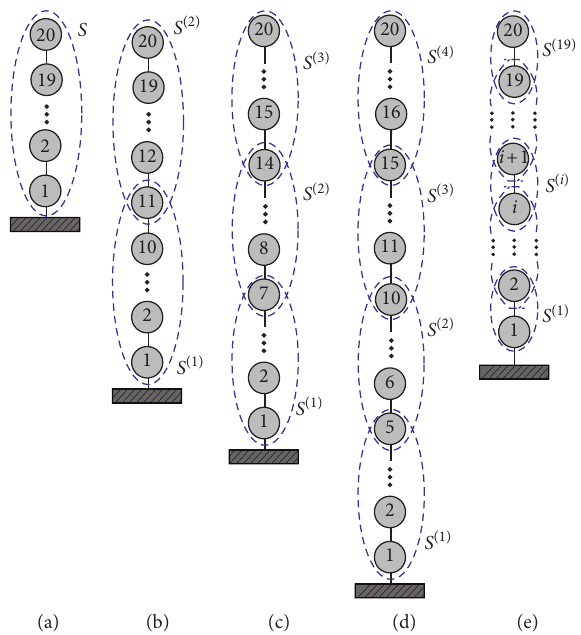
Figure 3: The design of controllers. (a) Centralized control. (b) ODC1 (c) ODC2. (d) ODC3. (e) ODC4.